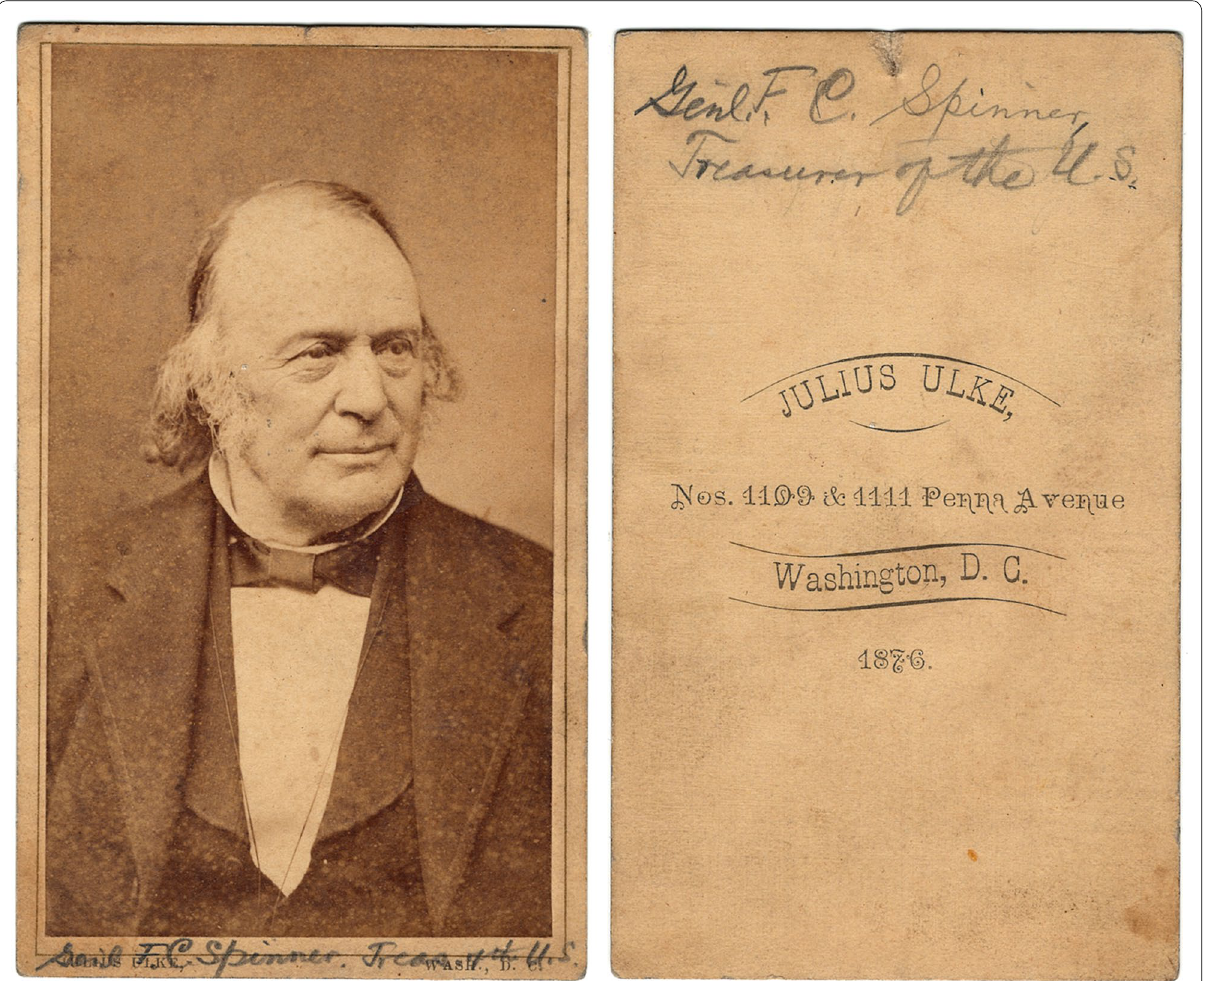
Fig. 2 Carte-de-visite photograph depicting Louis Agassiz, bearing the 1876 backstamp of Julius Ulke (ex Ulke Family Collection, Swann 2013, sale 2324, lot 328, in part); note the card was erroneously identified as ‘F.E. Spinner’, United States General and Treasurer, probably by Titus Ulke, Henry’s eldest son; courtesy of ERB